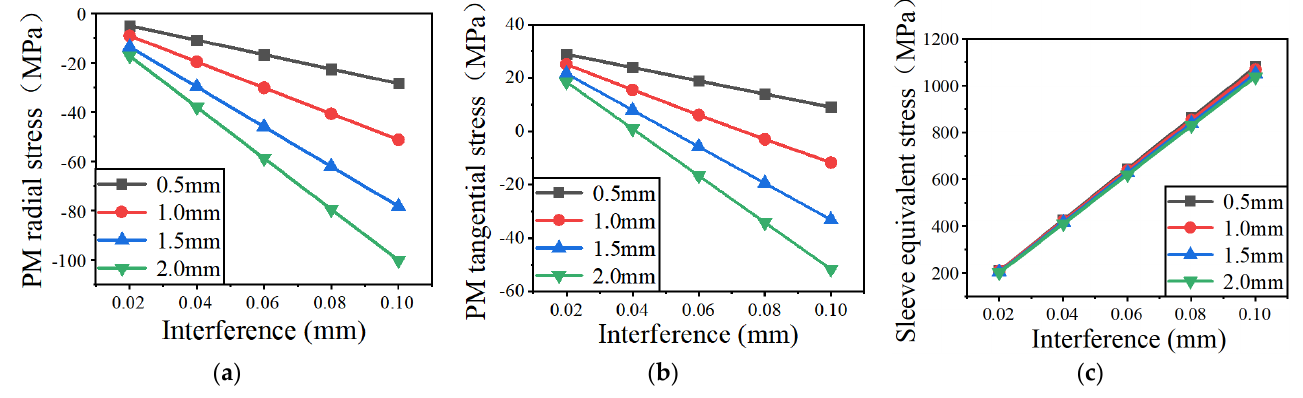
Figure 20. The maximum stress of the rotor variations with sleeve thickness and interference. ( a ) PM maximum radial stress; ( b ) PM maximum tangential stress; ( c ) sleeve maximum equivalent stress.